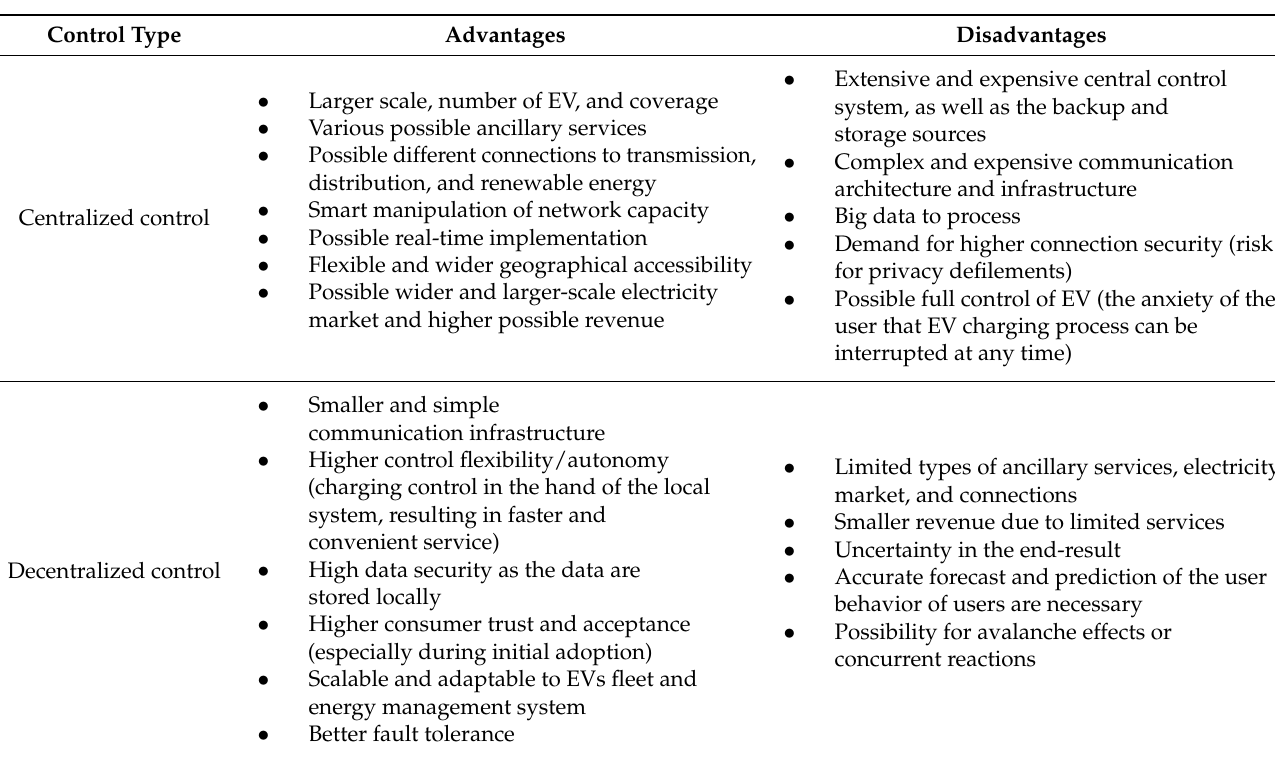
Table 2. Advantages and disadvantages of centralized and decentralized control architecture